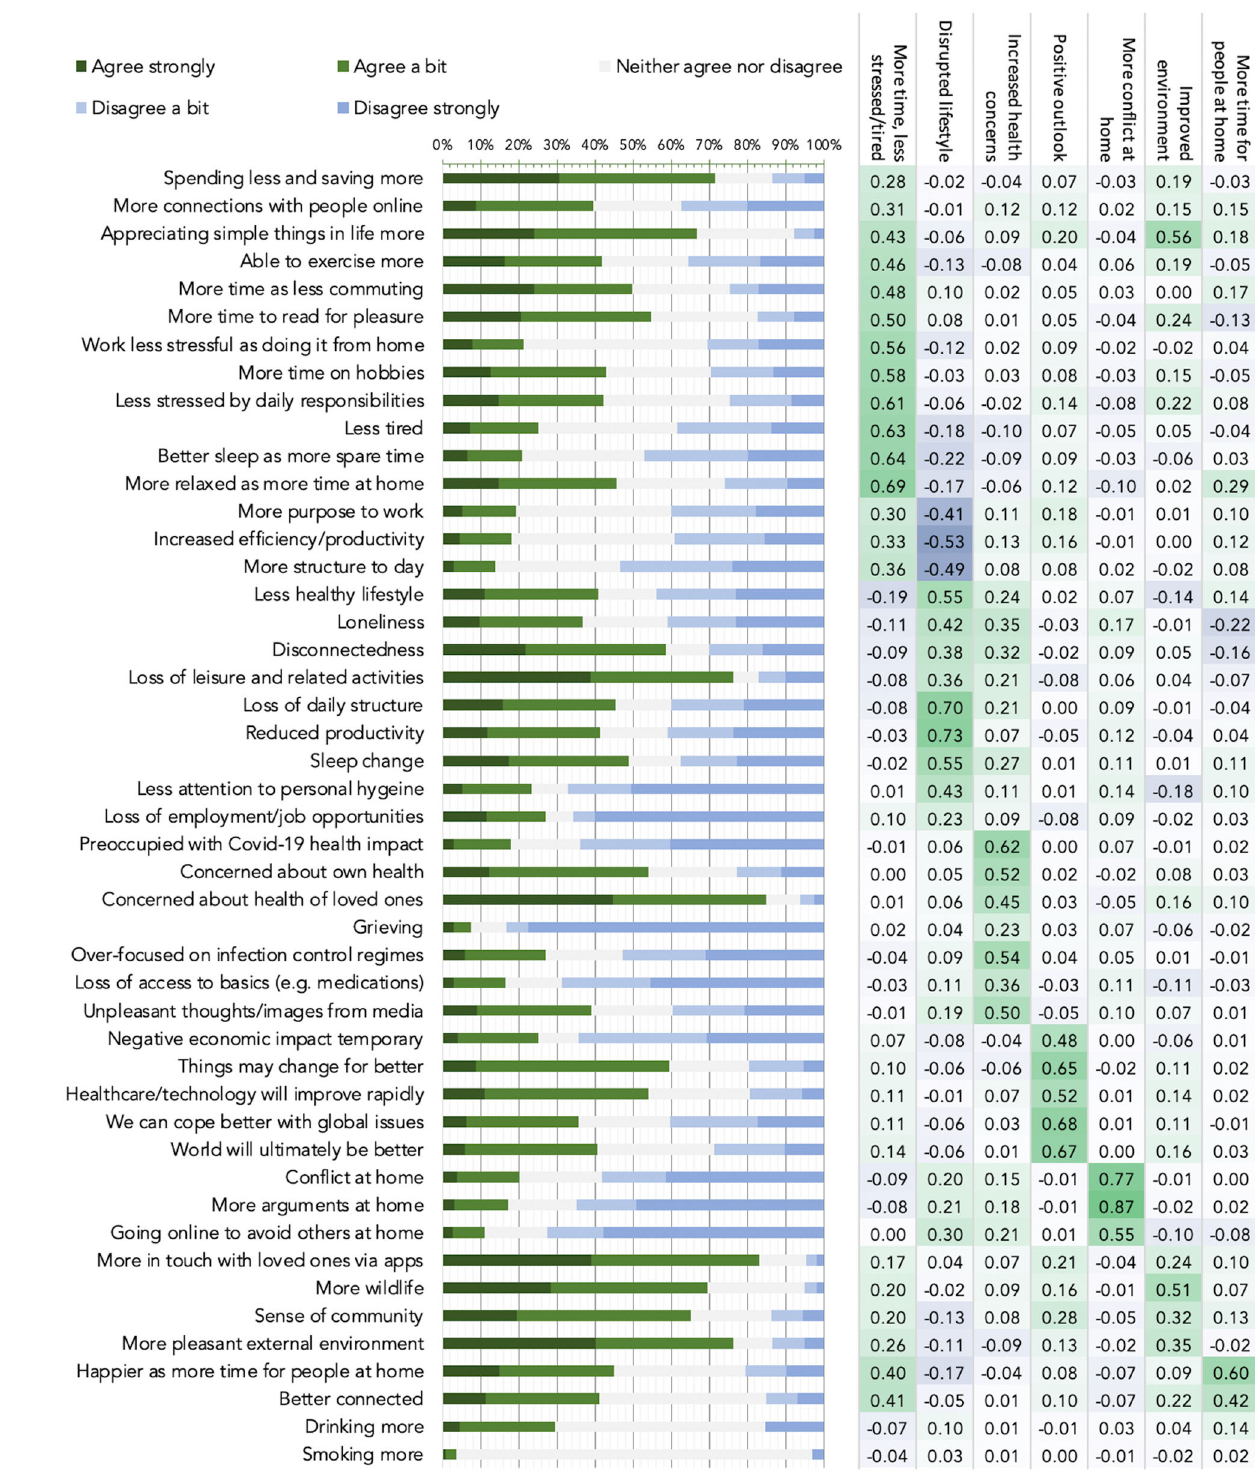
Fig. 4 Individual item responses and principal component analysis for the PD-GIS at peak UK lockdown. Left. Strength of agreement with statements about self-perceived pandemic impact — bars are proportion responses. Green = agree, blue = disagree. Abbreviated items are reported in full in Supplementary Methods. Right. Loadings from PCA, which identi fi ed 7 components underlying PD-GIS responses when applying permutation testing (Supplementary Fig. 10). These were labelled 1: more time and less stress and tiredness. 2: disrupted lifestyle. 3: increased health concern. 4: positive outlook. 5: more con fl ict at home. 6: improved environment. 7: more time for people at home. Source data are provided as a Source data fi